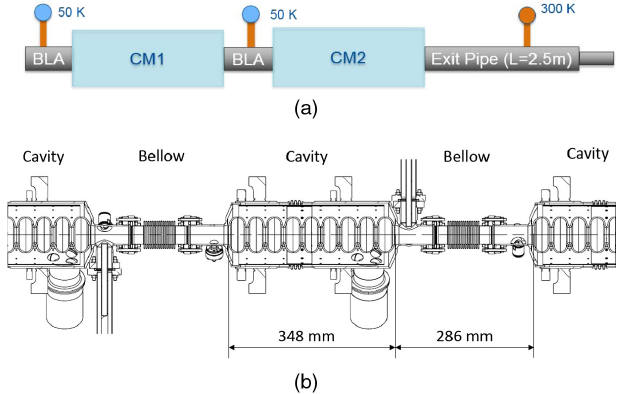
FIG. 1. (a) Scheme of the LCLS-II third-harmonic section. BLA is the HOM beam line absorber, and CM1 and CM2 are the first and second cryomodules, respectively. (b) Layout